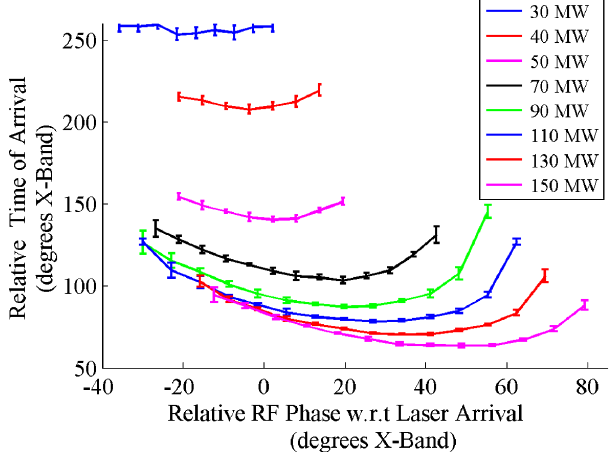
FIG. 16. Measured relative time of arrival (converted to phase at 11.424 GHz) versus rf phase relative to the laser arrival for different SLED-II power levels. The RF pulse length was 140 ns.